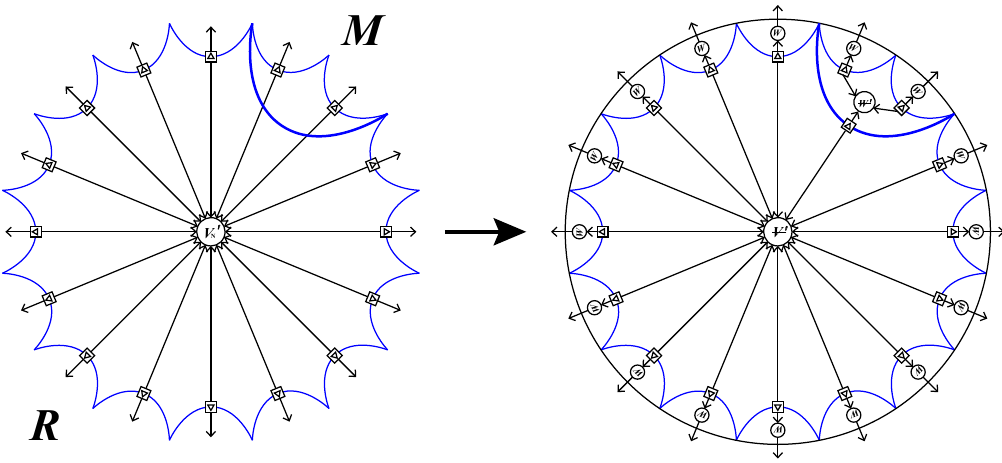
Figure 9 . The first step of the second layer. Note that we have drawn the φ tensor and σ tensor together for